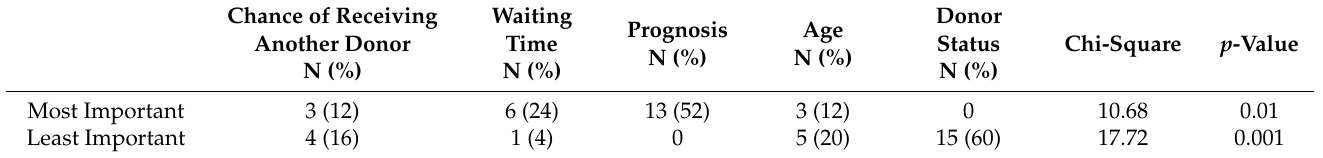
Table 4. Medical experts’ views about the most and least important factors in organ allocation.